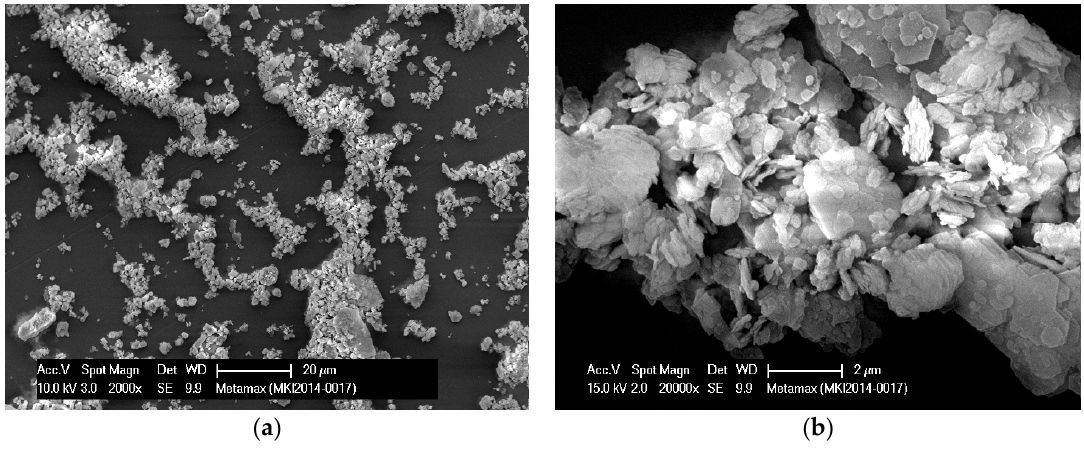
Figure 1. SEM photographs of metakaolin at: ( a ) 2000 times magnification; ( b ) 20,000 times magnification. Courtesy of BASF USA.